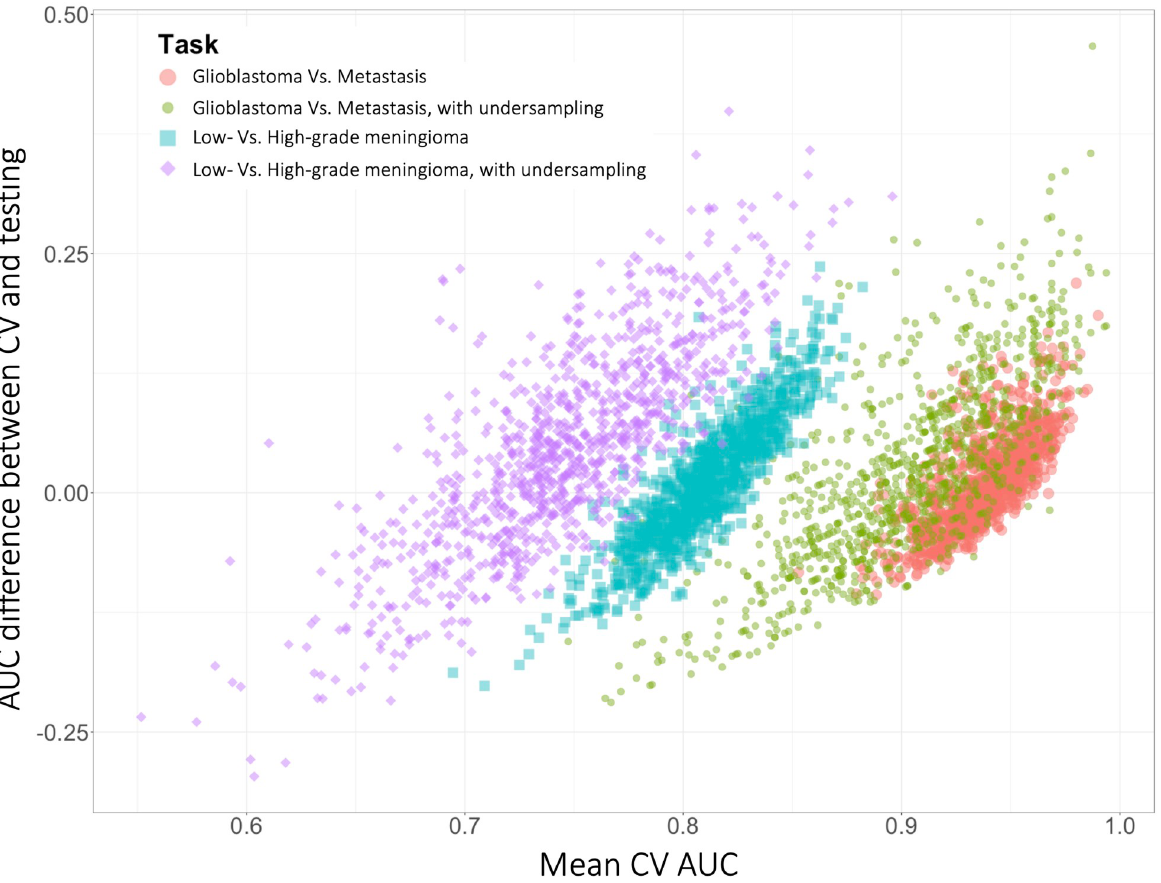
Fig 3. Model performance estimate and generalization gap in 1,000 different training-test set pairs according to the sample size and the level of task difficulty. Each point indicates a model performance estimate in the training set (X axis) and its gap from the performance in the test set (Y axis) from a single training-test set pair. Inspection of how closely clustered the datapoints are reveals that the variability in both the model performance estimation and the gap between CV and testing were worse with the difficult task and with undersampling.